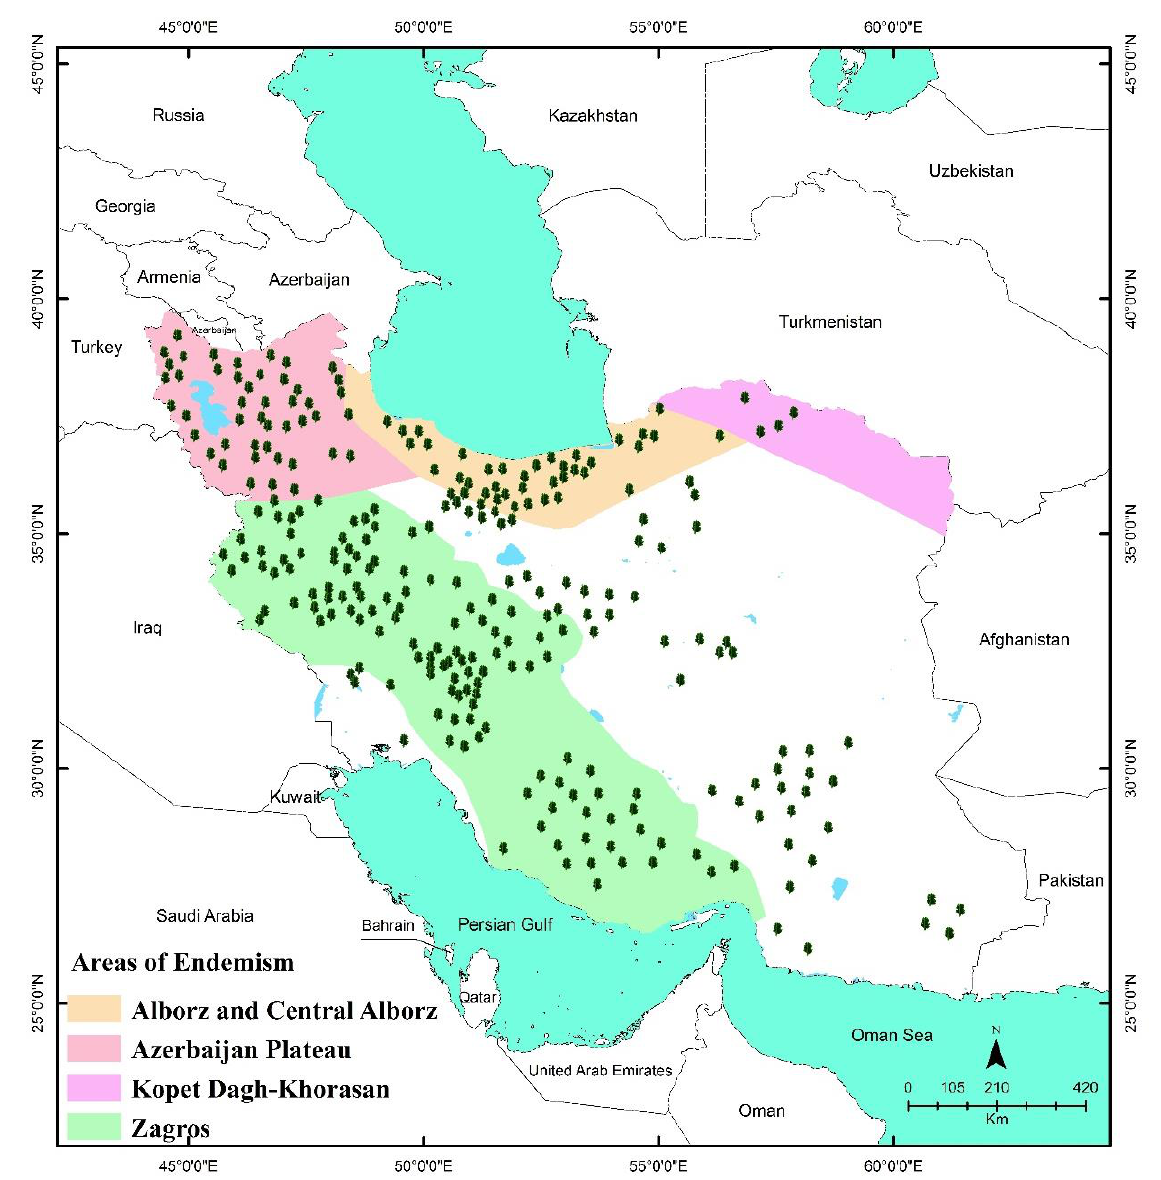
Figure 5. Distribution patterns of the endemic medicinal and aromatic plants of Iranian flora by endemism area.